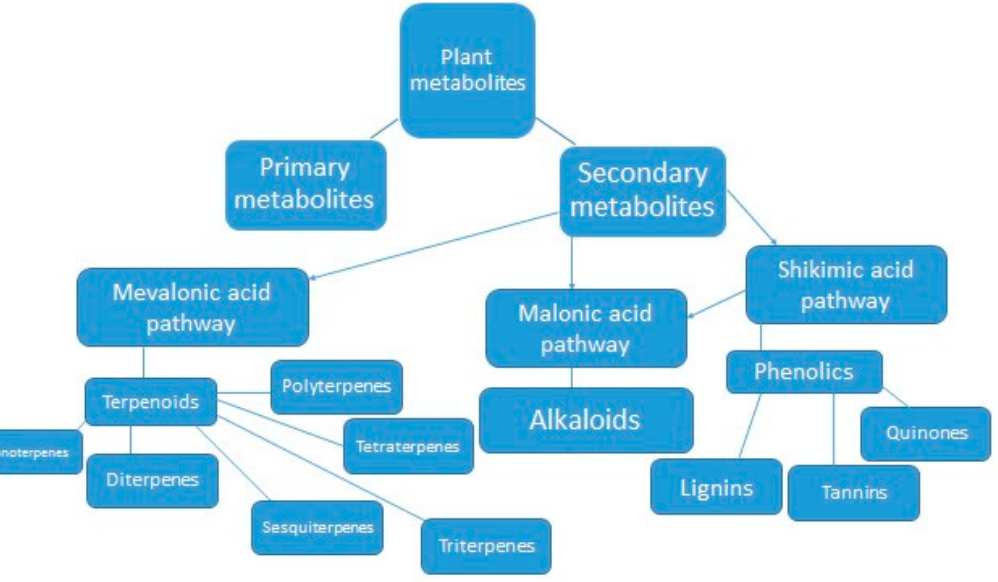
Figure 2. Formation of different kinds of secondary metabolites in plants, adapted from Mendoza and Silva [36] after modifications.